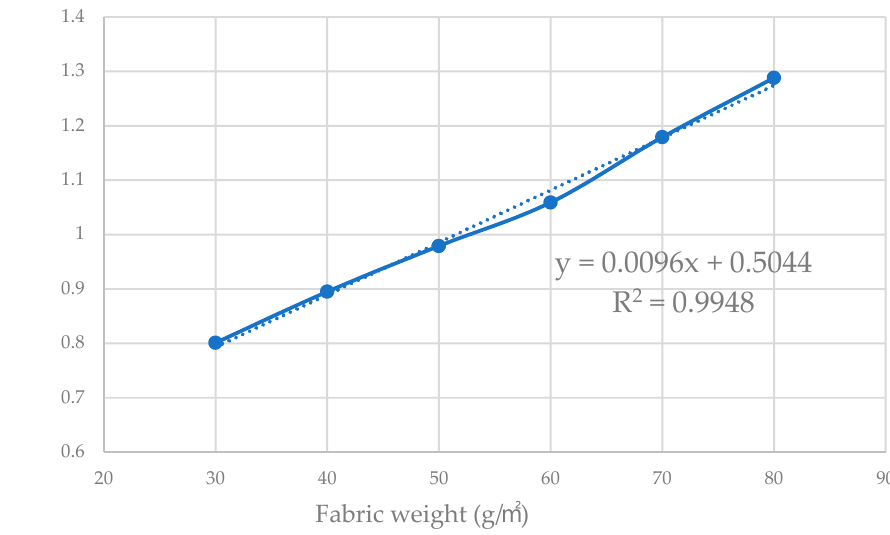
Figure 15. Fitting the relationship between the total flow and the gram weight of the conveyed fabric. The simulation results of this study are roughly the same as the expected results, and the pressure on the lower surface of the fabric is evenly distributed. The simulation